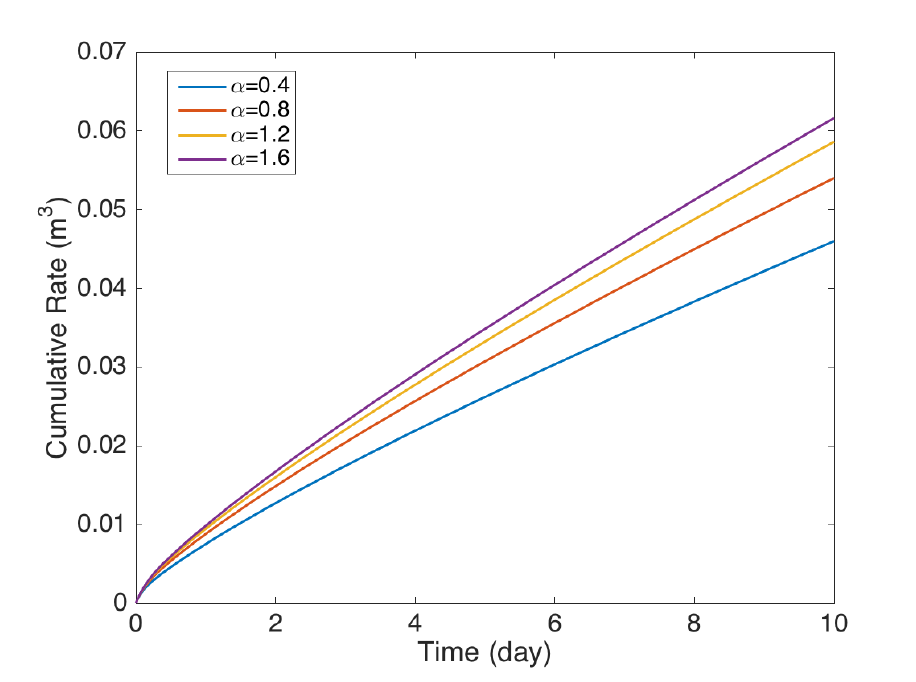
Figure 8. The cumulative production for various values of α .